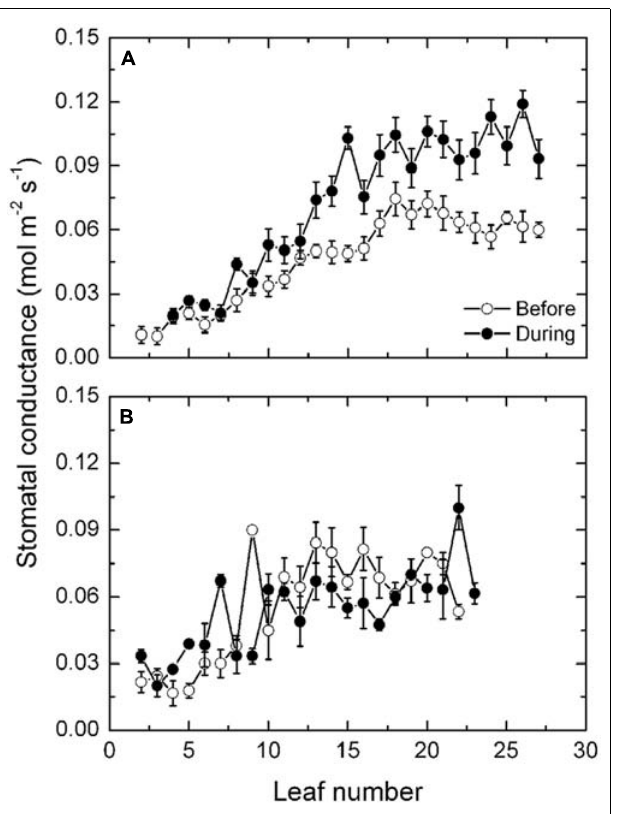
FIGURE 5 | (A,B) Stomatal conductance (mean ± SE, N = 12) at different leaf positions along the shoot of Semillon vines either prior to (7th January, 104 DAB) or one day (4th February, 132 DAB) during the 14-day period of high temperatures as indicated.The vines were grown in an irrigated vineyard (A) without protection and (B) with protection provided by shade cover over the vines.